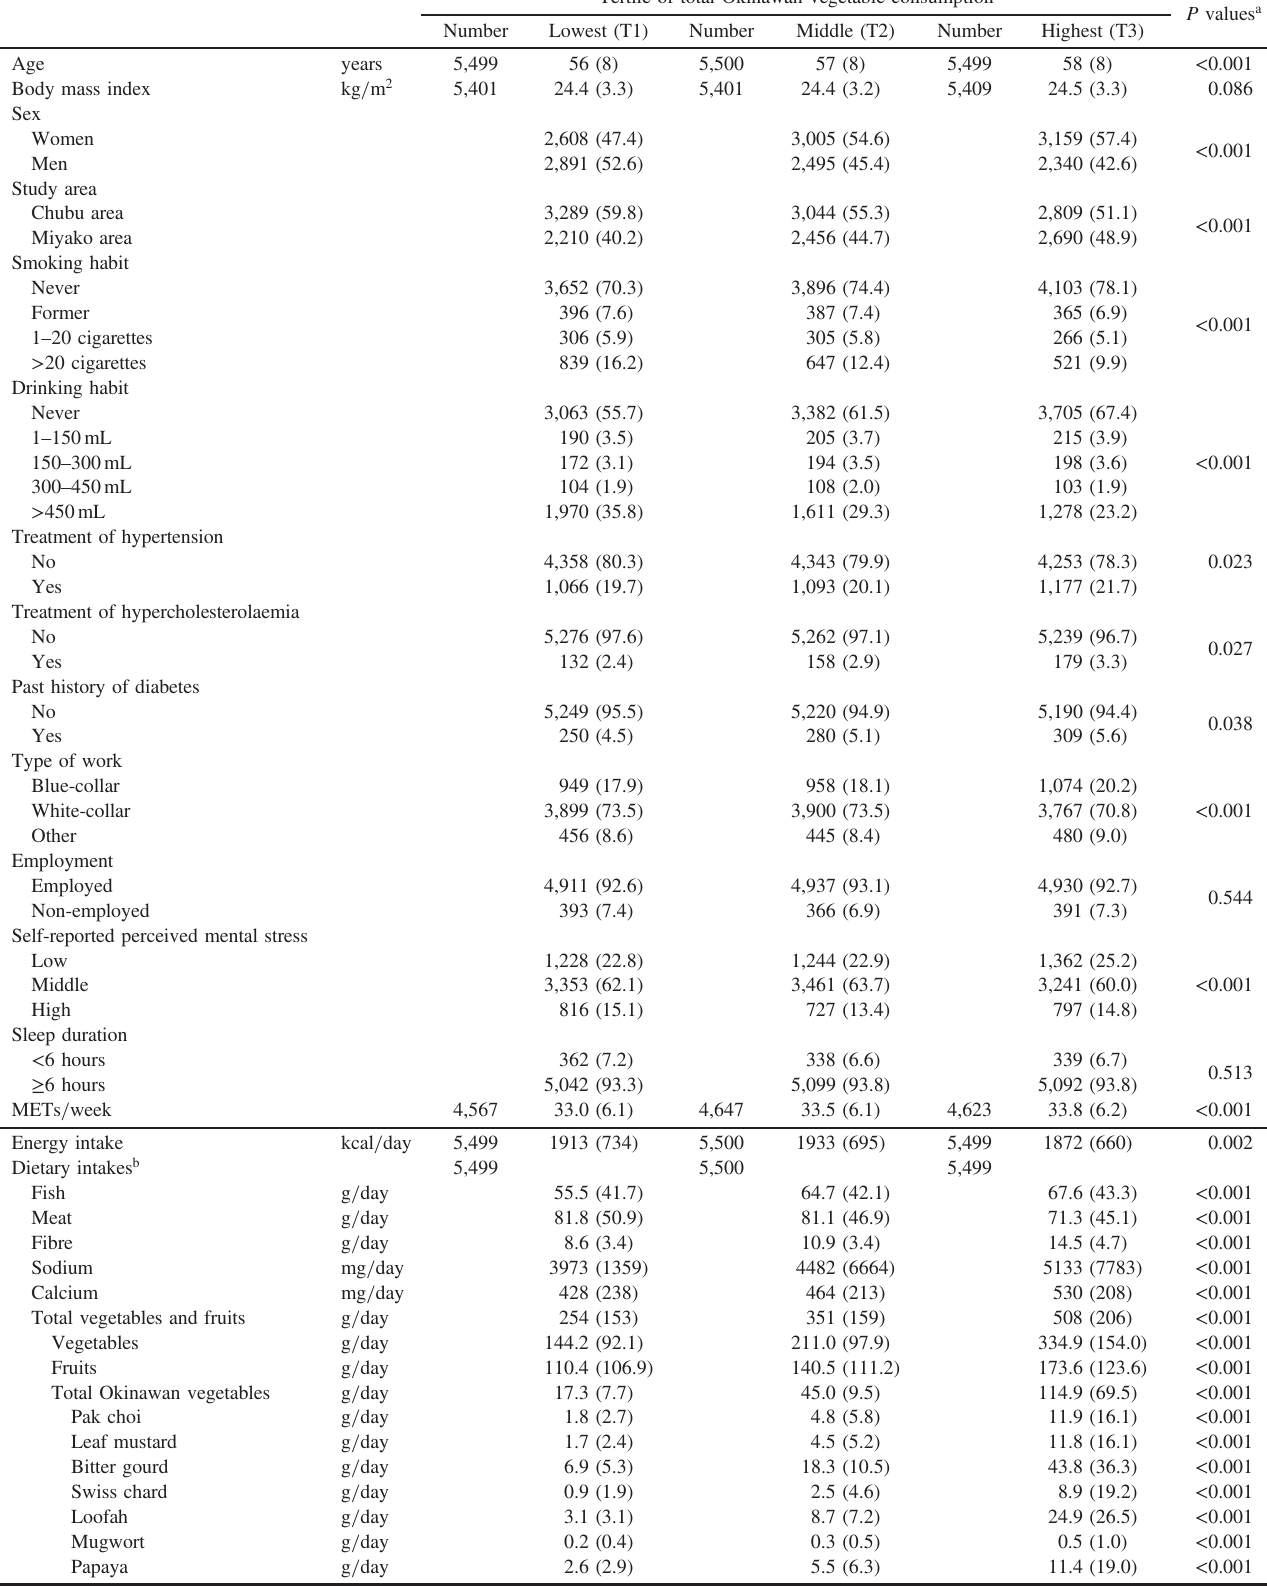
Tertile of total Okinawan vegetable